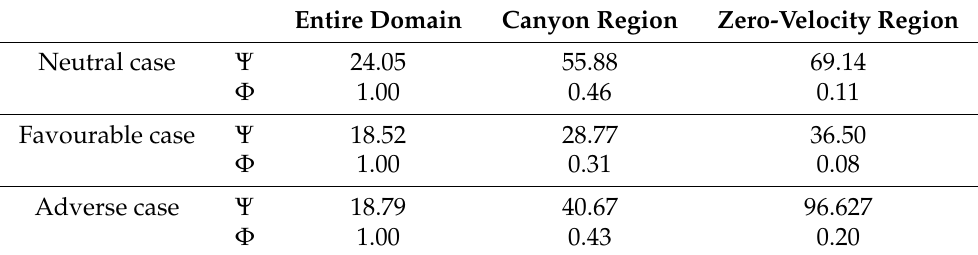
Table 3. Non-dimensional concentration density Ψ and the main recirculation quotient Φ within three selected regions: the entire domain (0 < z / H < 3), the canyon region (0 < z / H < 1.0), and the zero-velocity region (0 < z / H < 0.2). Percentage are computed with respect to the entire domain